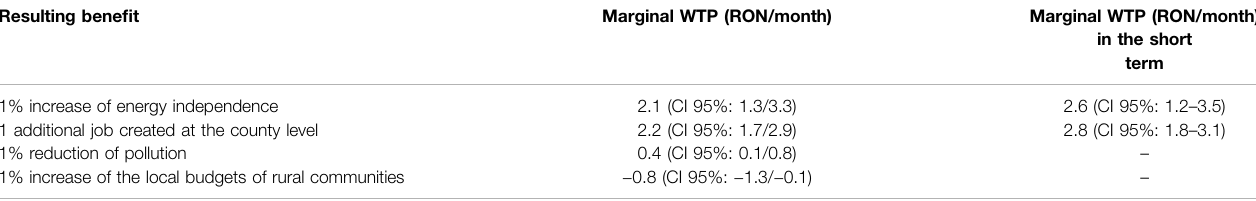
TABLE 8 | Households ’ marginal WTP for the societal bene fi ts attributable to the development of the RES sector. Resulting bene fi t Marginal WTP